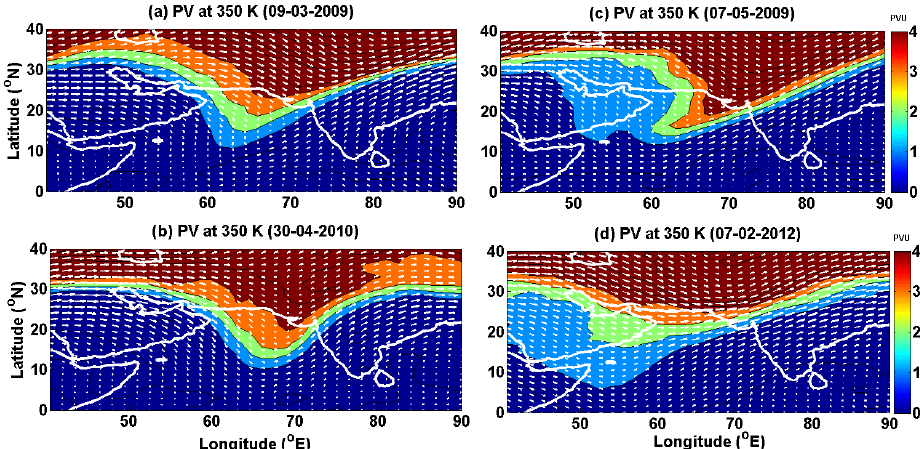
Figure 6. Longitude–latitude cross sections of PV and wind vector at 350K isentropic level for (a) 9 March 2009, (b) 7 May 2009, (c) 30 April 2010 and (d) 7 February 2012.